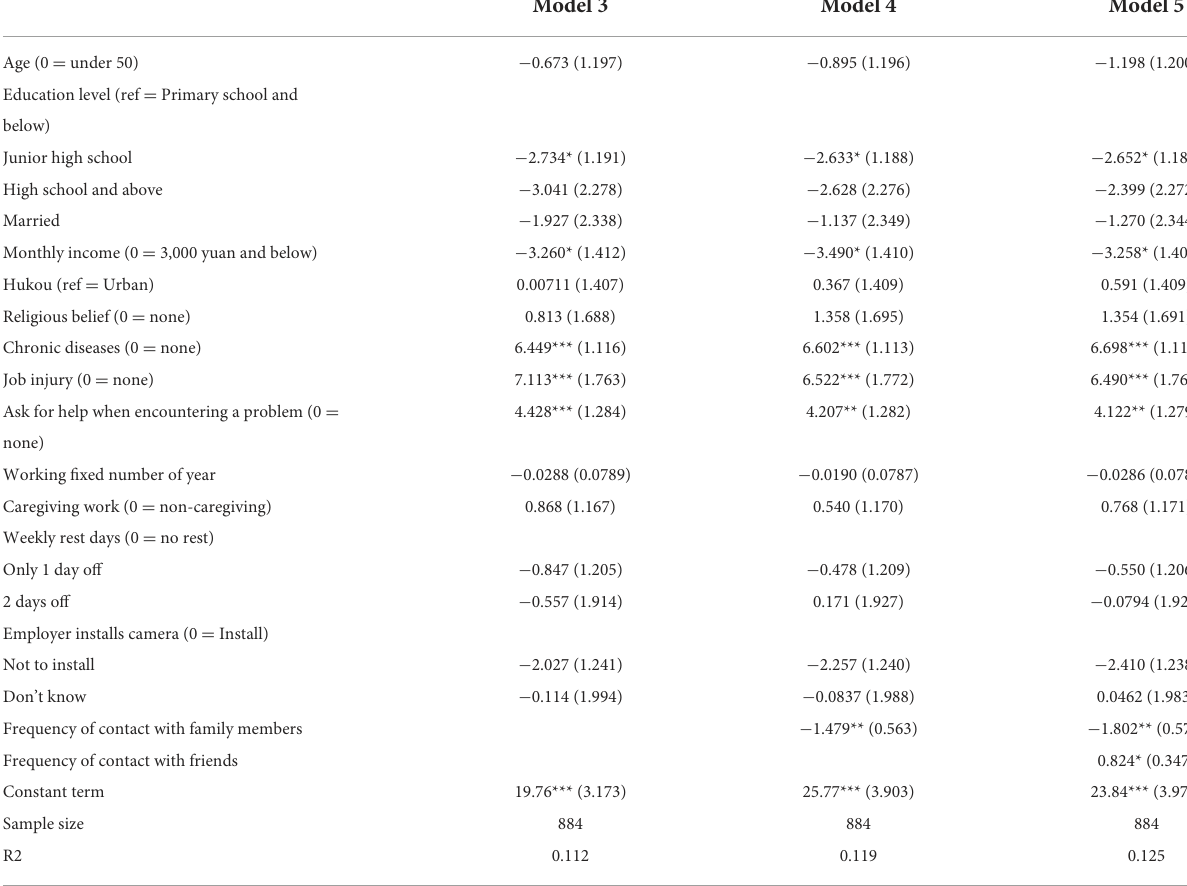
TABLE 4 Regression results of social network with different network attributes on mental health of domestic